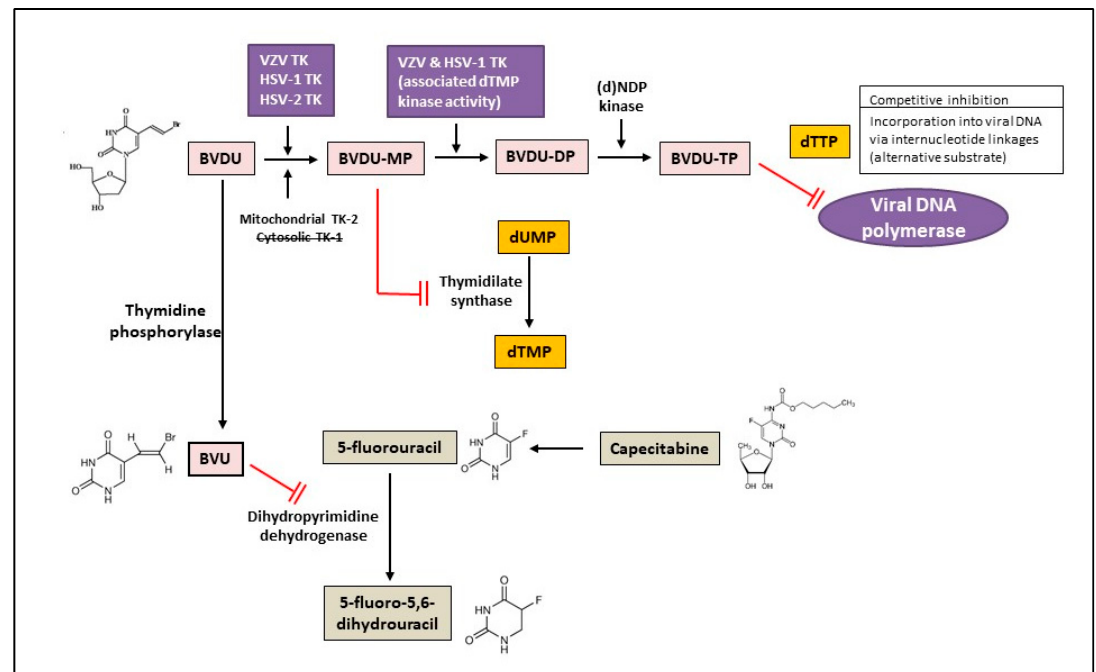
Figure 2. Activation, mechanism of action and catabolism of brivudine (BVDU). The VZV thymidine kinase (TK) as well as HSV ‐ 1 TK, display both thymidine kinase and thymidylate (dTMP) kinase activities, responsible for the activation of BVDU to the monophosphate (BVDU ‐ MP) and diphosphate (BVDU ‐ DP) forms, respectively. The conversion of BVDU ‐ DP to the active triphosphate metabolite (BVDU ‐ TP) is carried out by the cellular nucleoside 5 ′‐ diphosphate (NDP) kinase. BVDU ‐ TP is recognized by DNA polymerases as an alternative substrate and is incorporated into the DNA molecule via internucleotide linkages. Pyrimidine nucleoside analogues, such as BVDU and BVaraU, can be degraded by pyrimidine catabolic enzymes (such as uridine phosphorylase or thymidine phosphorylase (TPase) leading to their free base metabolites without antiviral activity. BVDU cannot be administered together with 5 ‐ flurouracil or its prodrug capecitabine because BVU (the product formed following BVDU degradation by the thymidine phsophorylase), is a potent inhibitor of dihydropyrimidine dehydrogenase. This enzyme is needed for the first step in the catabolic pathway of pyrimidines and for 5 ‐ fluorouracil degradation and hence co ‐ administration of 5 ‐ fluorouracil and brivudine leads to increased exposure to 5 ‐ fluorouracil.